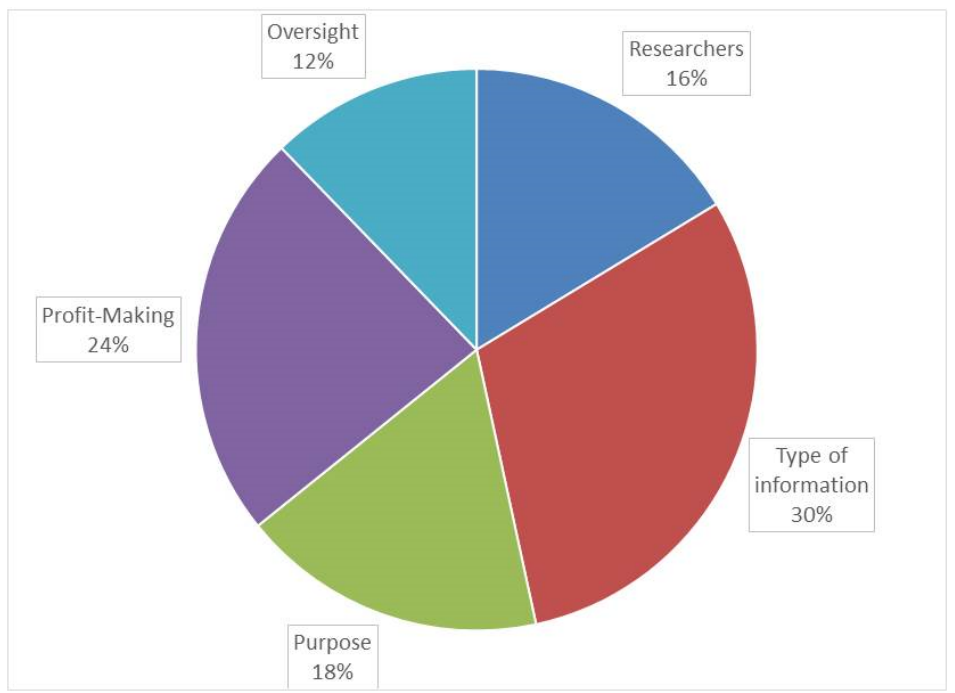
Figure 1: Relative Importance of